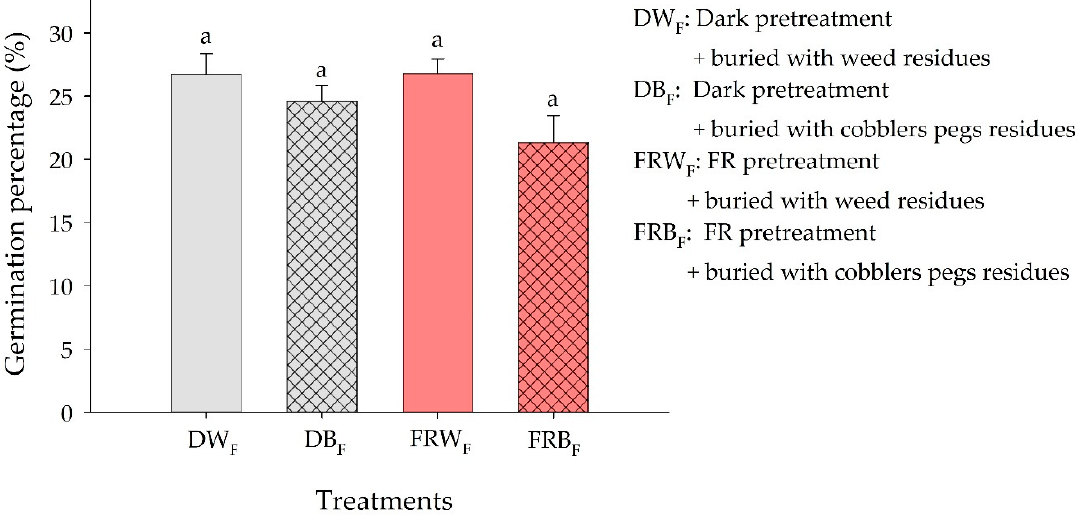
Figure 8. The effects of FR pretreatment and different residues on the Cobbler’s pegs seed germination in the field. Error bars are the standard error ( n = 12). The same letters indicate no significant difference at p < 0.05 Dunn’s post hoc comparison test.